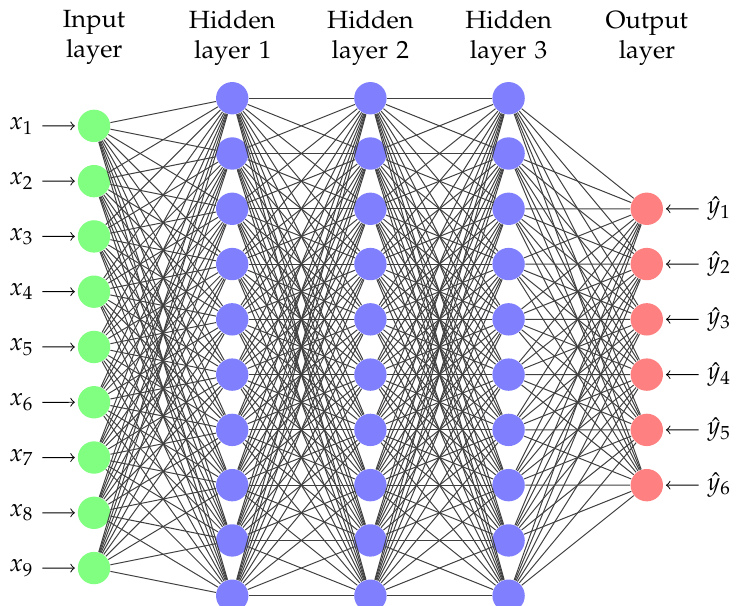
Figure 4. Schematic structure of an MLP neural network similar to the one used in this study.